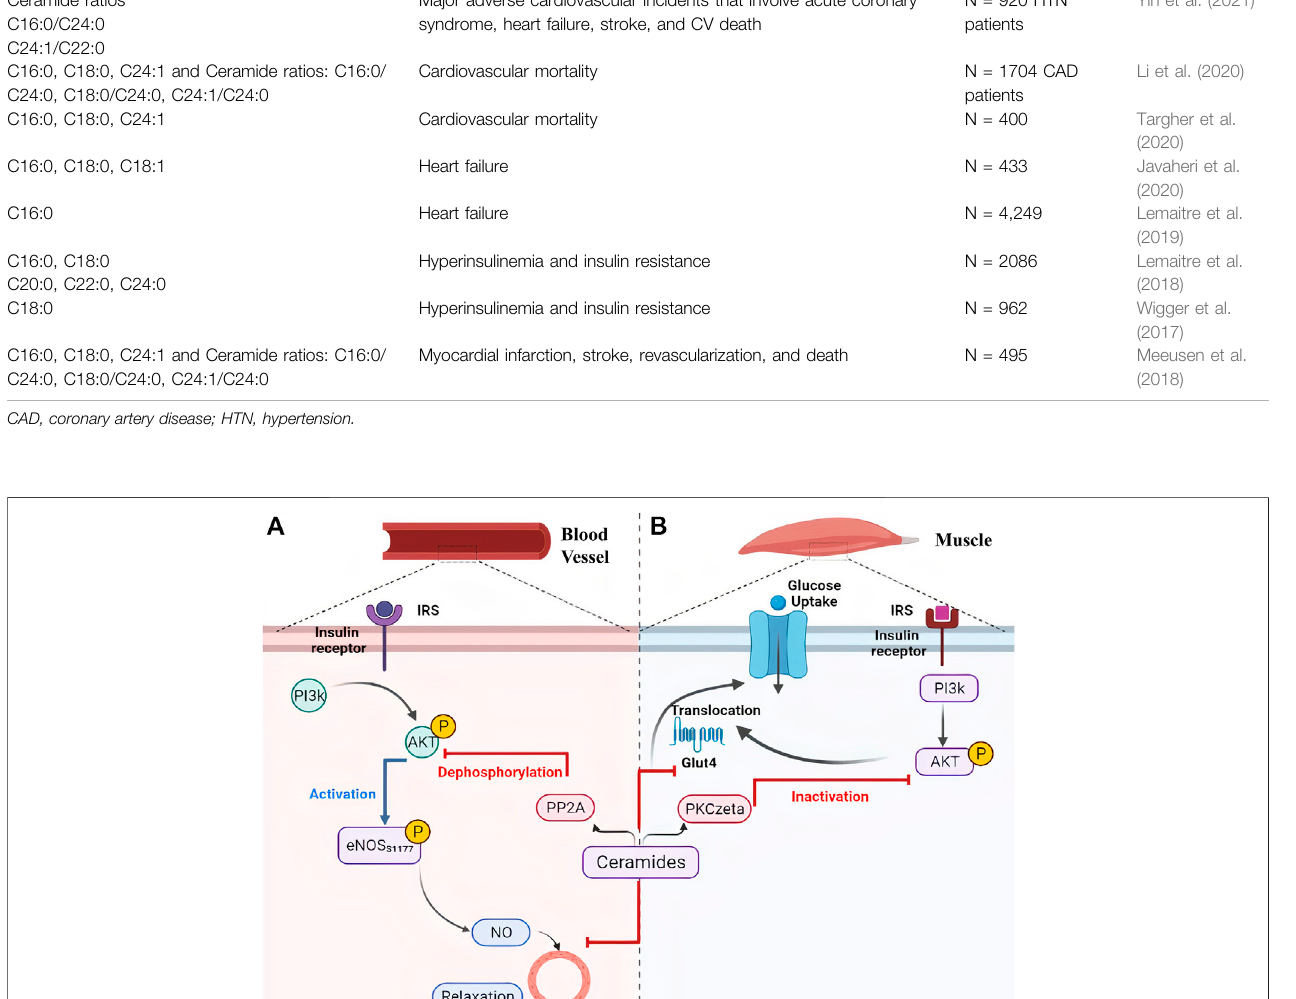
Frontiers in Cell and Developmental Biology |